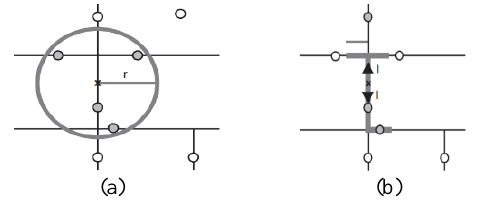
Figure 3. The difference between the NKDE and